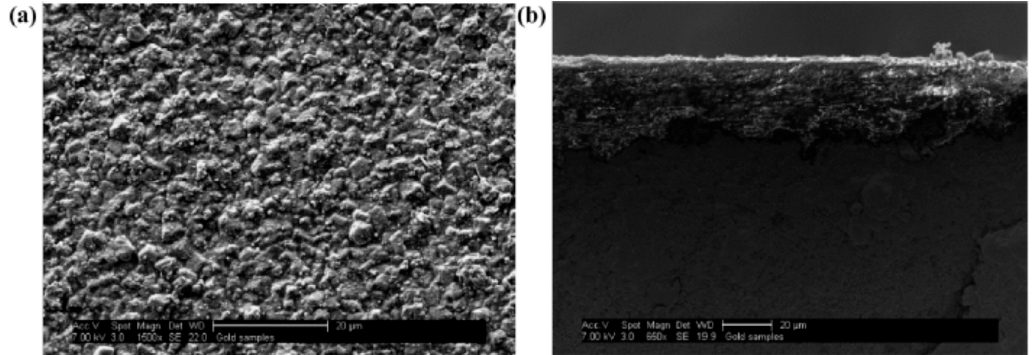
Figure 8. ZIF-68 membrane synthesis step following in situ growth of ZnO on Al 2 O 3 SEM micrographs showing ZIF-68 membrane layer formed following secondary growth at ( a ) 1500 × and ( b ) a cross-sectional picture at 660 × ; Reproduced with permission from [18].